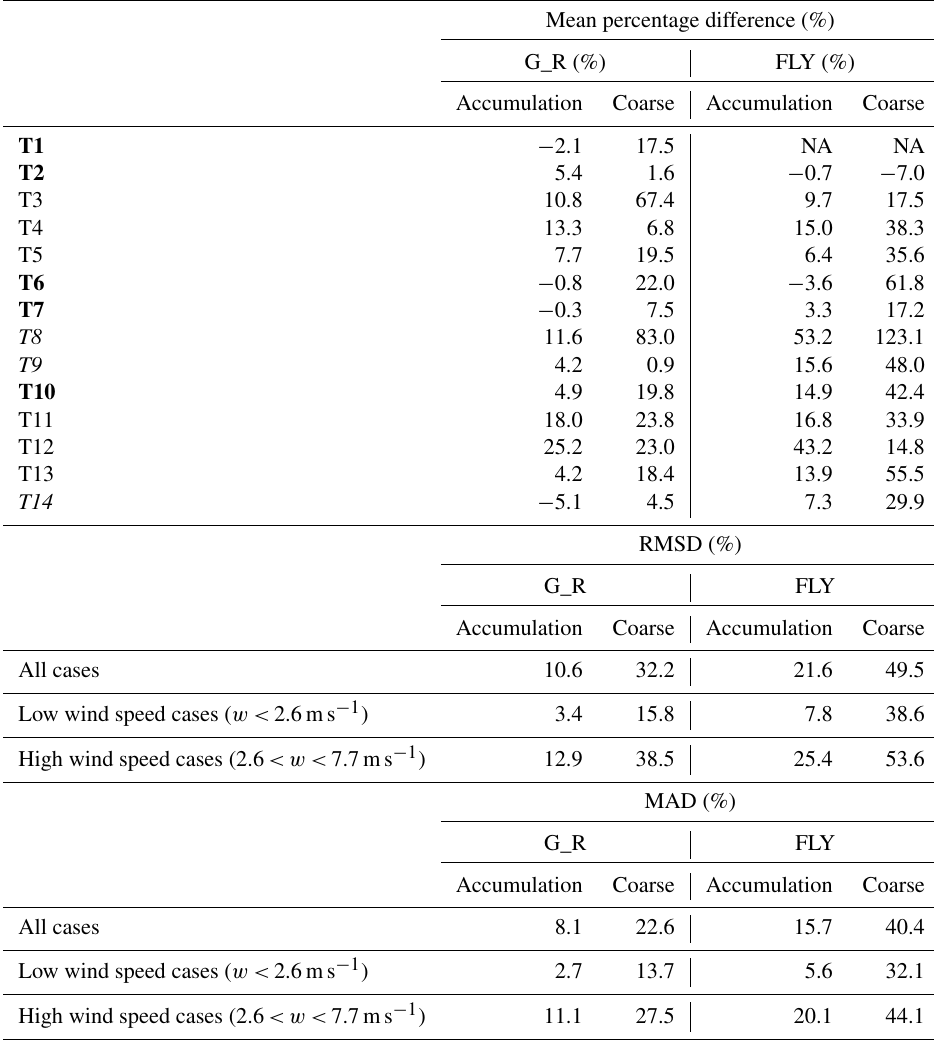
Table 5. Summary of mean percentage differences of size distribution between G_NR and G_R and between G_NR and FLY of each flight. The size distributions are separated into two modes: accumulation mode (0.1 ≤ d ≤ 1µm) and coarse mode ( d >